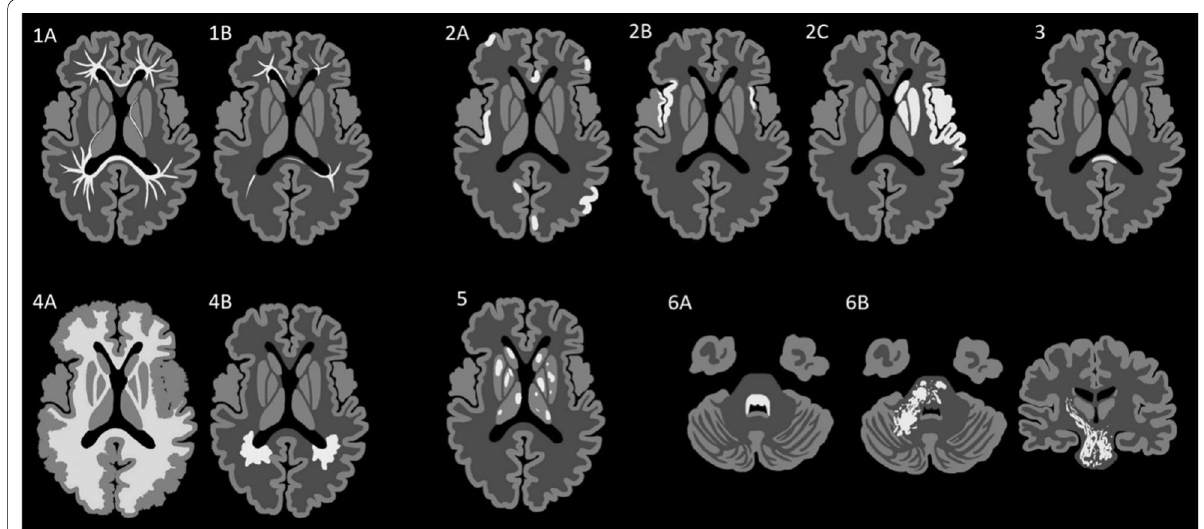
Fig. 1 General MRI patterns of paediatric brain infections. Composite images of disease patterns overlaid on generic axial sections through the supratentorial brain (level of basal ganglia and third ventricle) and infratentorial brain (mid‑pons and 4th ventricle), as well as a coronal section through the basal ganglia and third ventricle. Each key pattern on MRI has been allocated a number, with subdivisions indicated by a letter. Pattern 1: Restricted diffusion in supratentorial white matter (A—diffuse, B—limited). Pattern 2: Restricted diffusion in supratentorial grey matter injury (A—scattered, B—mesial temporal lobe(s), C—vascular territory). Pattern 3: Restricted diffusion in corpus callosum. Pattern 4: T2 hyperintensity in supratentorial white matter (A—with neuronal migration abnormality, B—without neuronal migration abnormality). Pattern 5: T2 hyperintensity in the basal ganglia and/or thalami. Pattern 6: T2 hyperintensity in the posterior fossa (A—dorsal pons, B—diffuse brainstem with longitudinal tract involvement)